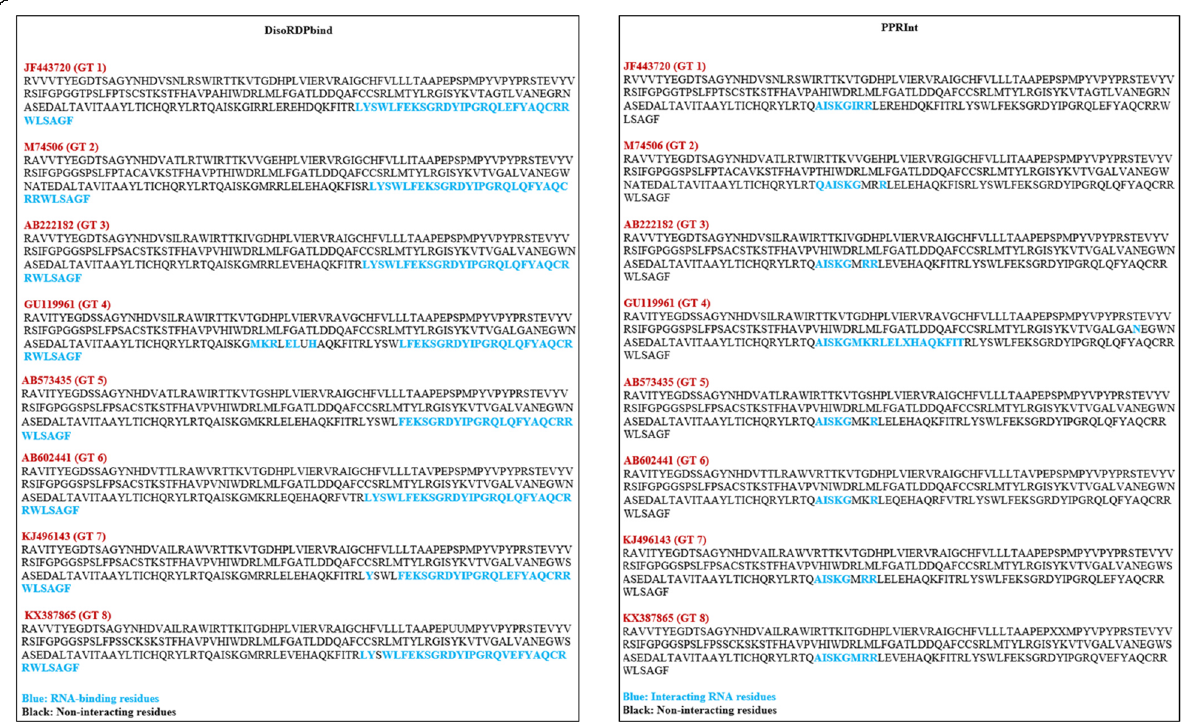
Fig. 6 A Analysis of RNA-binding propensity of HEV YDR, i.e., JF443720 (GT 1), M74506 (GT 2), AB222182 (GT 3), GU119961 (GT 4), AB573435